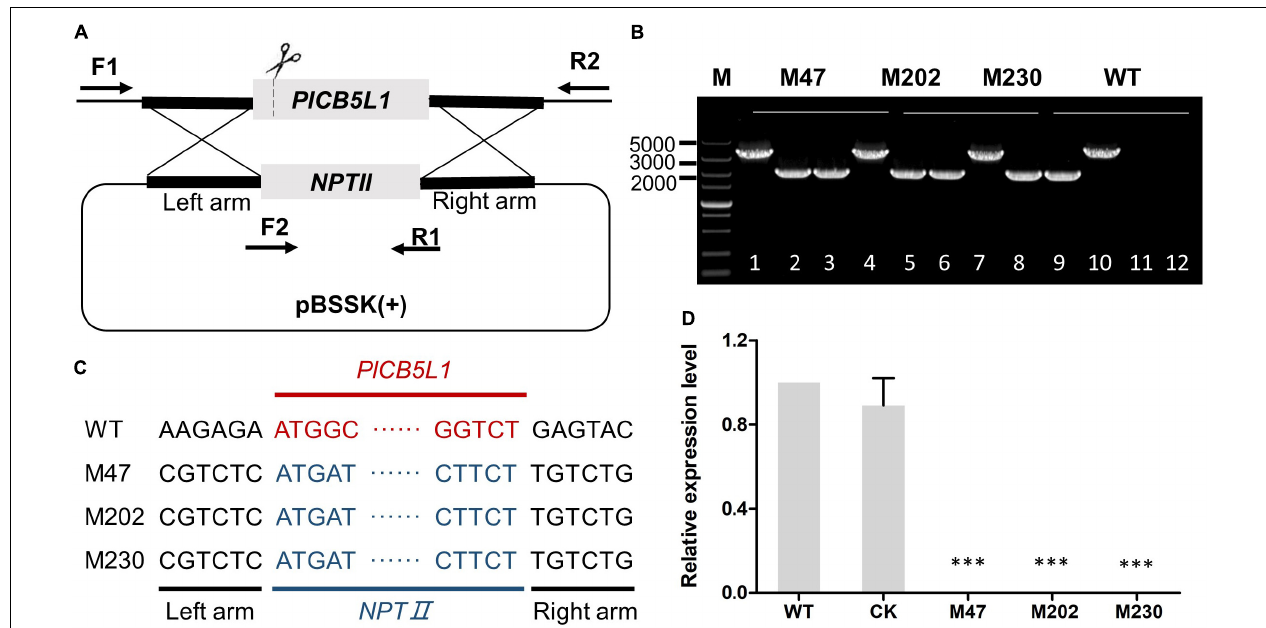
FIGURE 1 | Gene knockout of PlCB5L1 . (A) CRISPR/Cas9-mediated knockout of PlCB5L1 , in which the NPTII gene replaces the PlCB5L1. The primers (F1, R1, and F2, R2) used for PCR analysis are indicated by horizontal arrows. F1: Left-out-F; F2: NPTII-F; R1: NPTII-R; R2: Left-out-R ( Supplementary Table 1 ). (B) Genomic DNA PCR analysis of the (cid:49) plcb5l1 mutants. Marker: DL 5000. Lane 1, lane 4, lane 7, and lane 10 were amplifying with primers F1/R2. Lane 2, lane 5, lane 8, and lane 11 were amplifying with primers F1/R1. Lane 3, lane 6, lane 9, and lane 12 were amplifying with primers F2/R2. (C) Sequence analysis of the (cid:49) plcb5l1 mutants. (D) Relative gene expression levels of PlCB5L1 in mutants and CK strains. The expression level of WT was set as 1. Data are mean ± SD ( n = 9). Asterisks represent significant difference (*** p < 0.001) based on statistics analysis using Student’s t